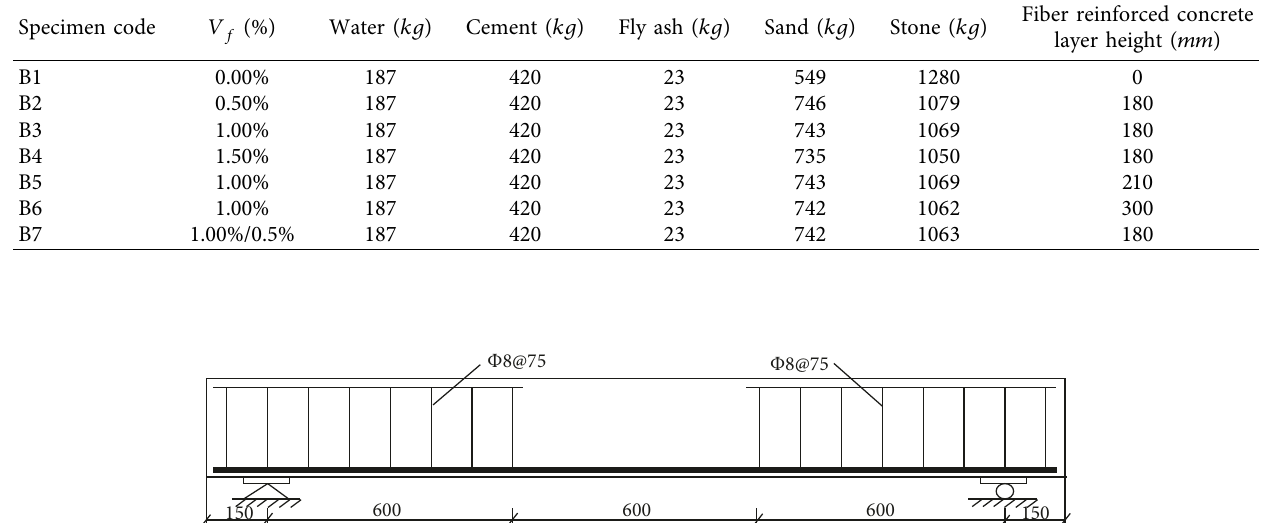
Table 2: Mix proportions of specimens.